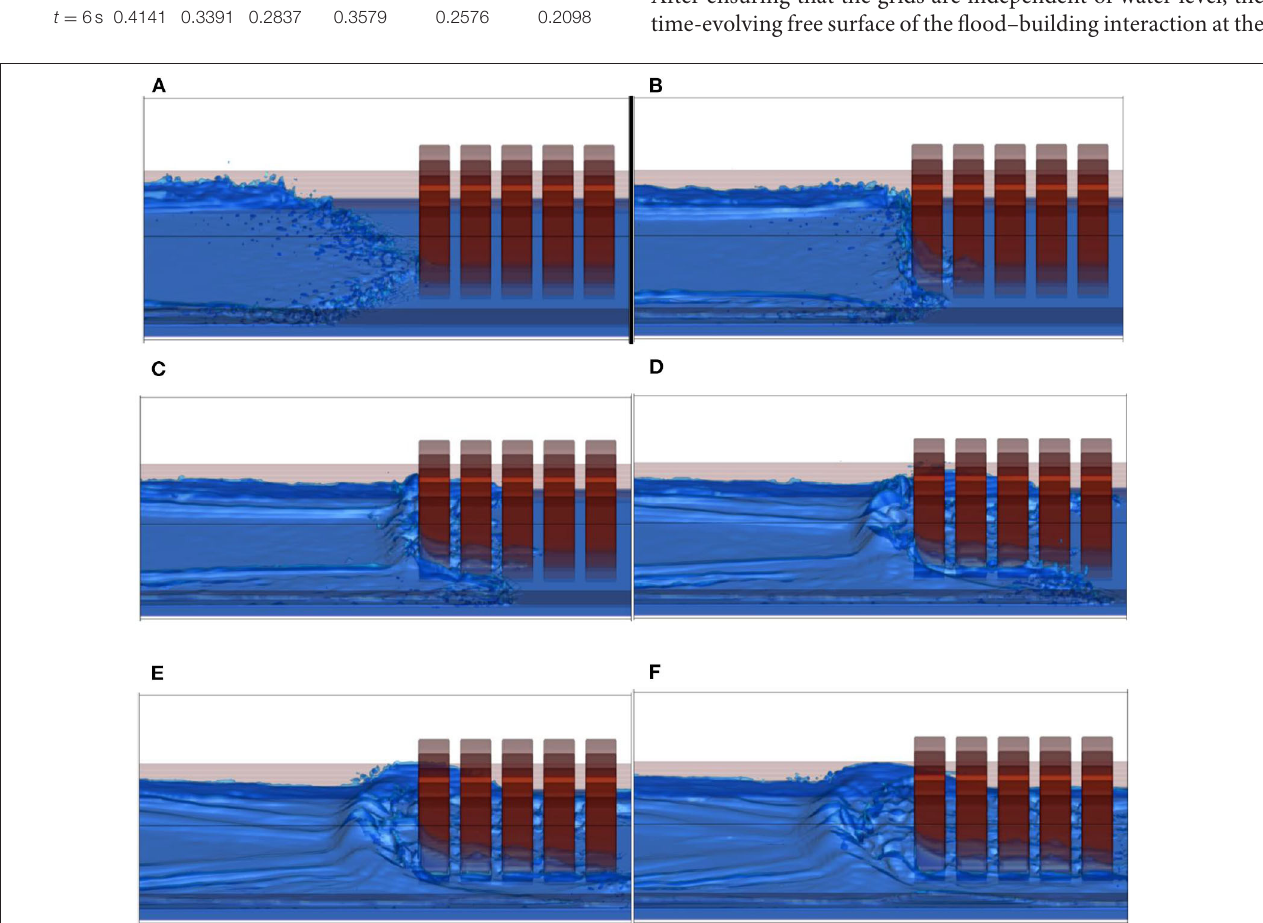
FIGURE 3 | Time evolution of the free surface at different times. (A) t